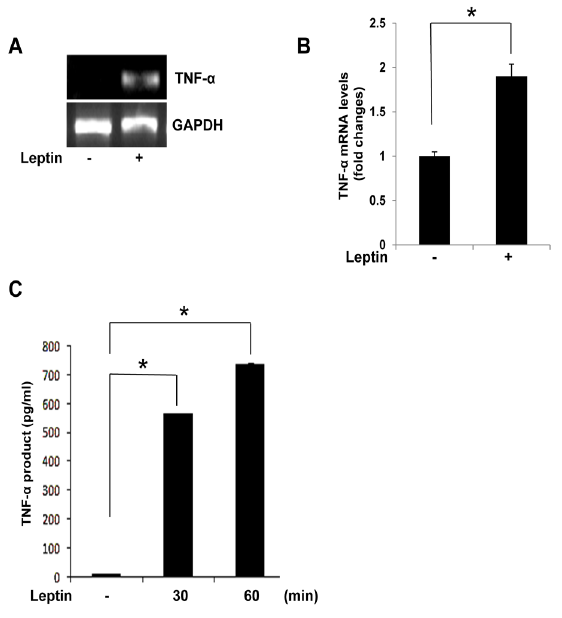
Figure 1. Effect of leptin on TNF- a expression in Raw 264.7 cells. (A,B) Raw 264.7 cells were treated with leptin (20 nM) for 30 min. Total RNA was isolated using TRIzol reagent, and mRNA levels were determined by semi-quantitative and real-time RT-PCR with primers for TNF- a or GAPDH. *p , 0.05 vs control. (C) For ELISA, cells in 96-well culture plates were treated with leptin (20 nM) for the indicated times. Results are the mean 6 S.E. for each group of samples. Data are means 6 S.E. of eight values. *p , 0.05 vs